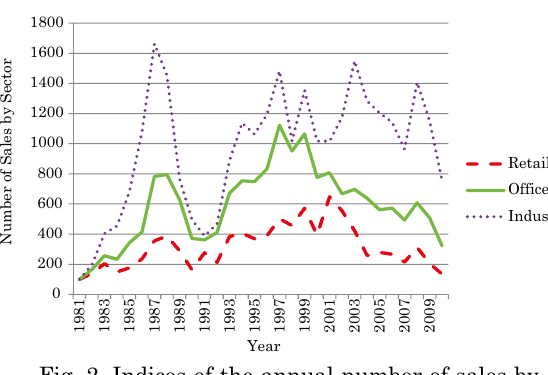
fig. 2. Indices of the annual number of sales by property sector 1981–2010 (1981 =